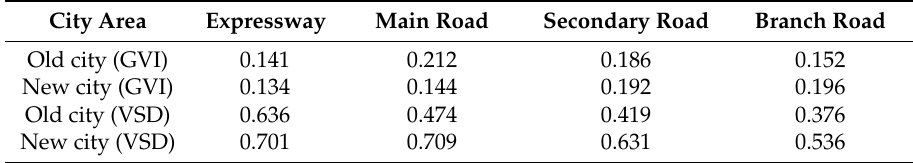
Table 8. Mean GVI / VSD of di ff erent road levels in the main city, the old city and new